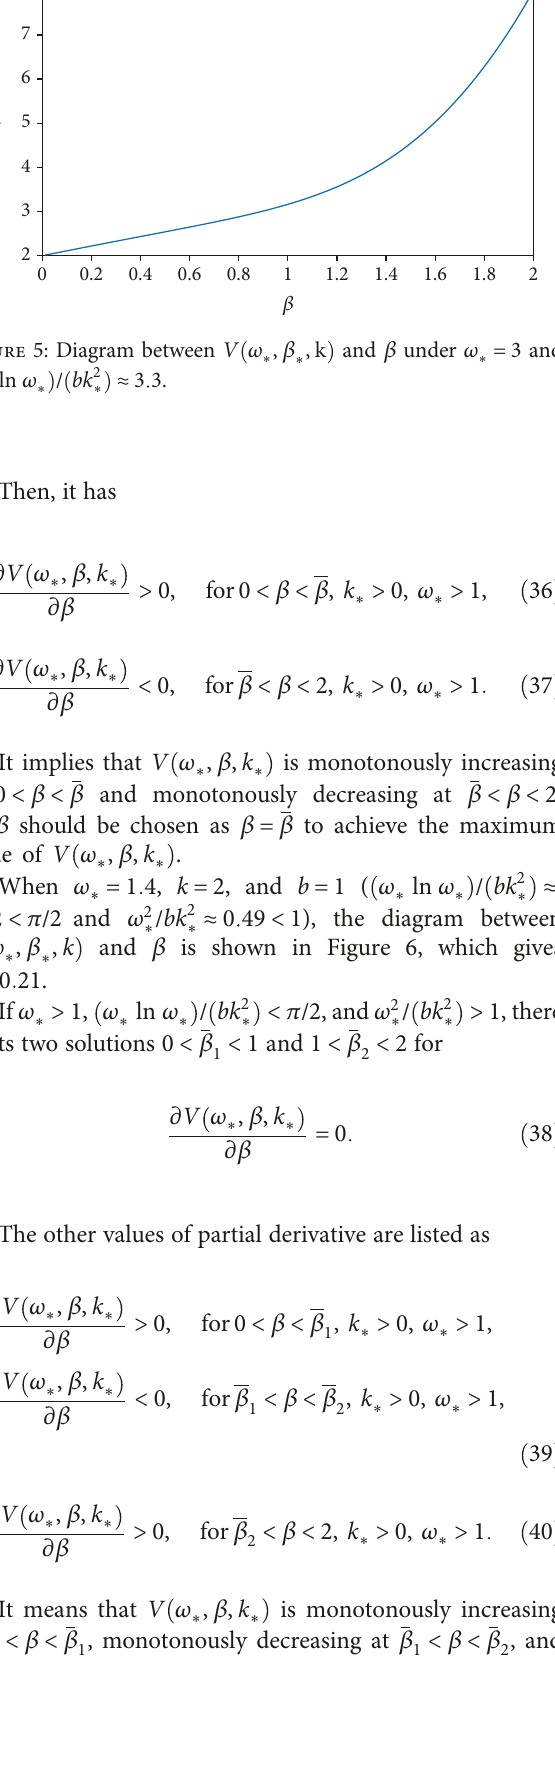
Figure 6: Diagram between V ω